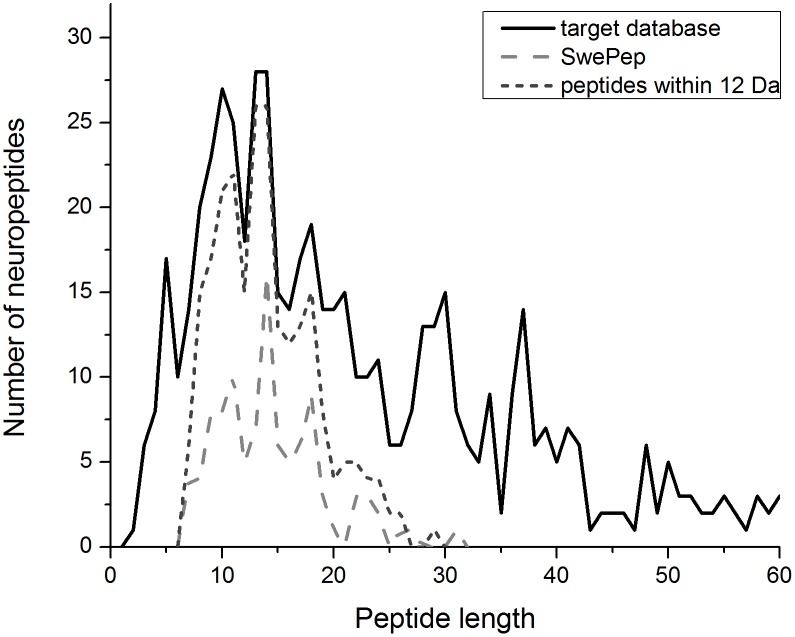
Distribution of neuropeptides length in target database peptides (less than 60 amino acid in length are shown), 103 studied peptides, and 236 peptides that fall within ±12 Da of the 103 peptides.